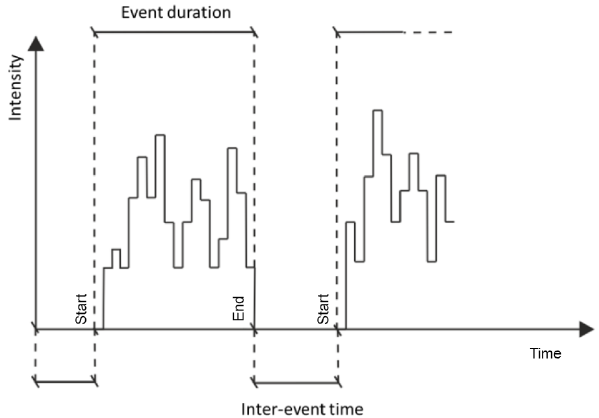
Figure 2. Diagram of the construction of the synthetic (resampled) rainfall